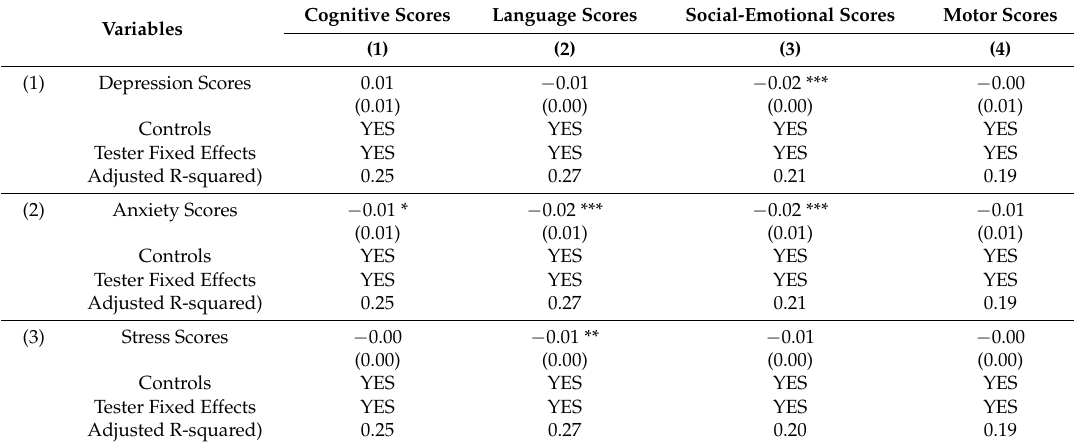
Table 5. Correlations between caregiver’s mental health and child development outcomes using ordinary least squares, n =